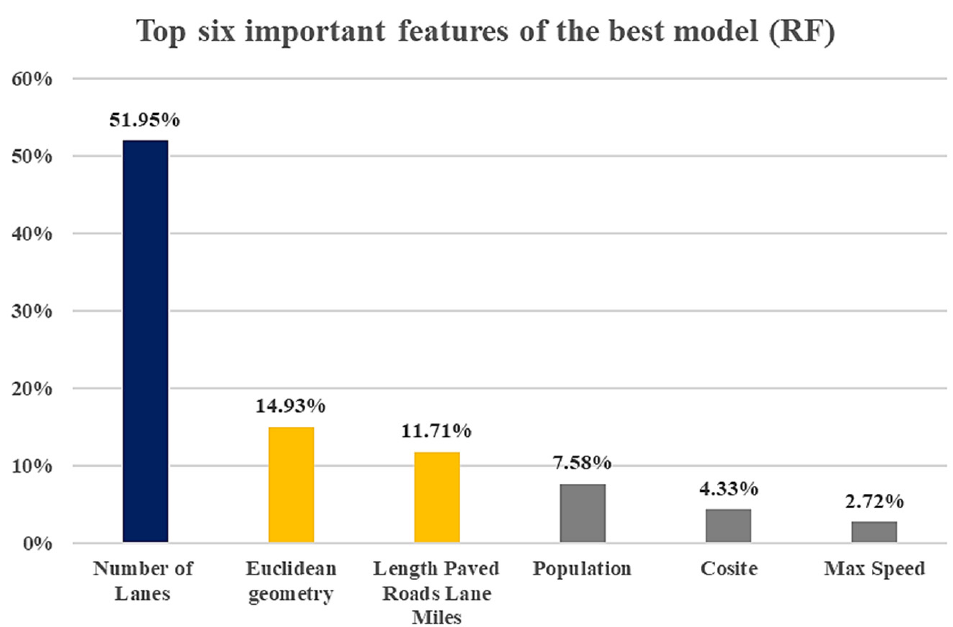
Figure 19. Feature importance derived from the best-performing models for total PVs (for the model with spatial variables).